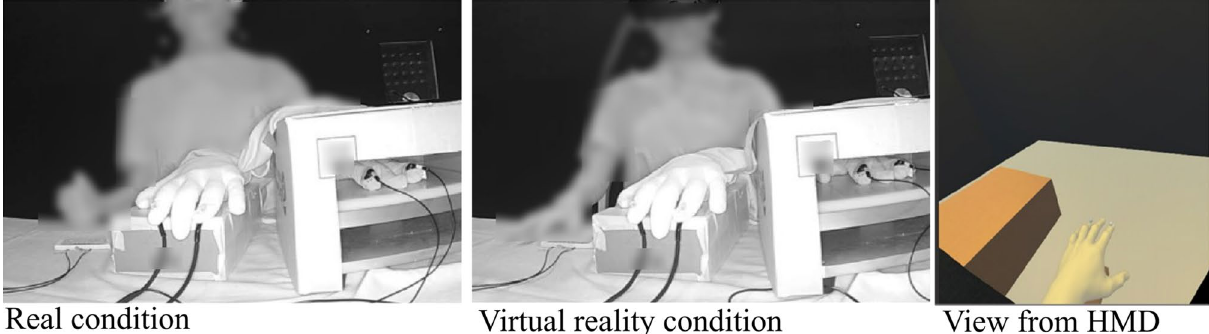
Figure 1. Experimental settings for the RHI in both real and VR environments. The left figure shows a participant viewing the real visual space, in which the real kitchen glove was located in front of the participant, while a cardboard box and black cloth occluded the participant model’s left arm and hand. The center figure shows the VR experimental set up (shown in the right